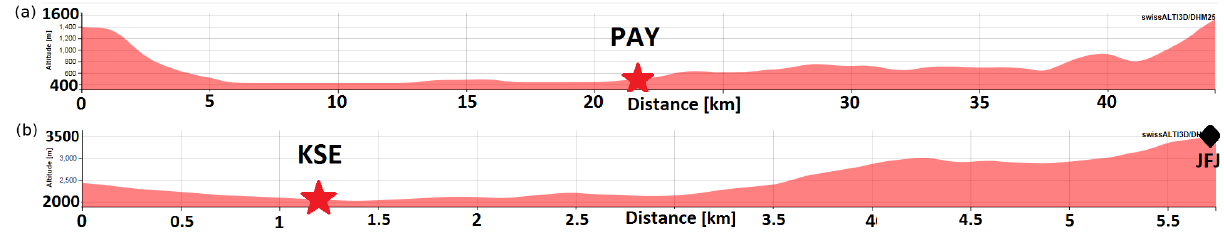
Figure 1. Topography of PAY (elevation profile along the 127.2 ◦ azimuth) and KSE (elevation profile along the 151.6 ◦ azimuth) as provided by the federal office of topography (http://www.geo.admin.ch/). The red stars mark the position of the ceilometers at PAY and KSE; the black diamond marks the JFJ